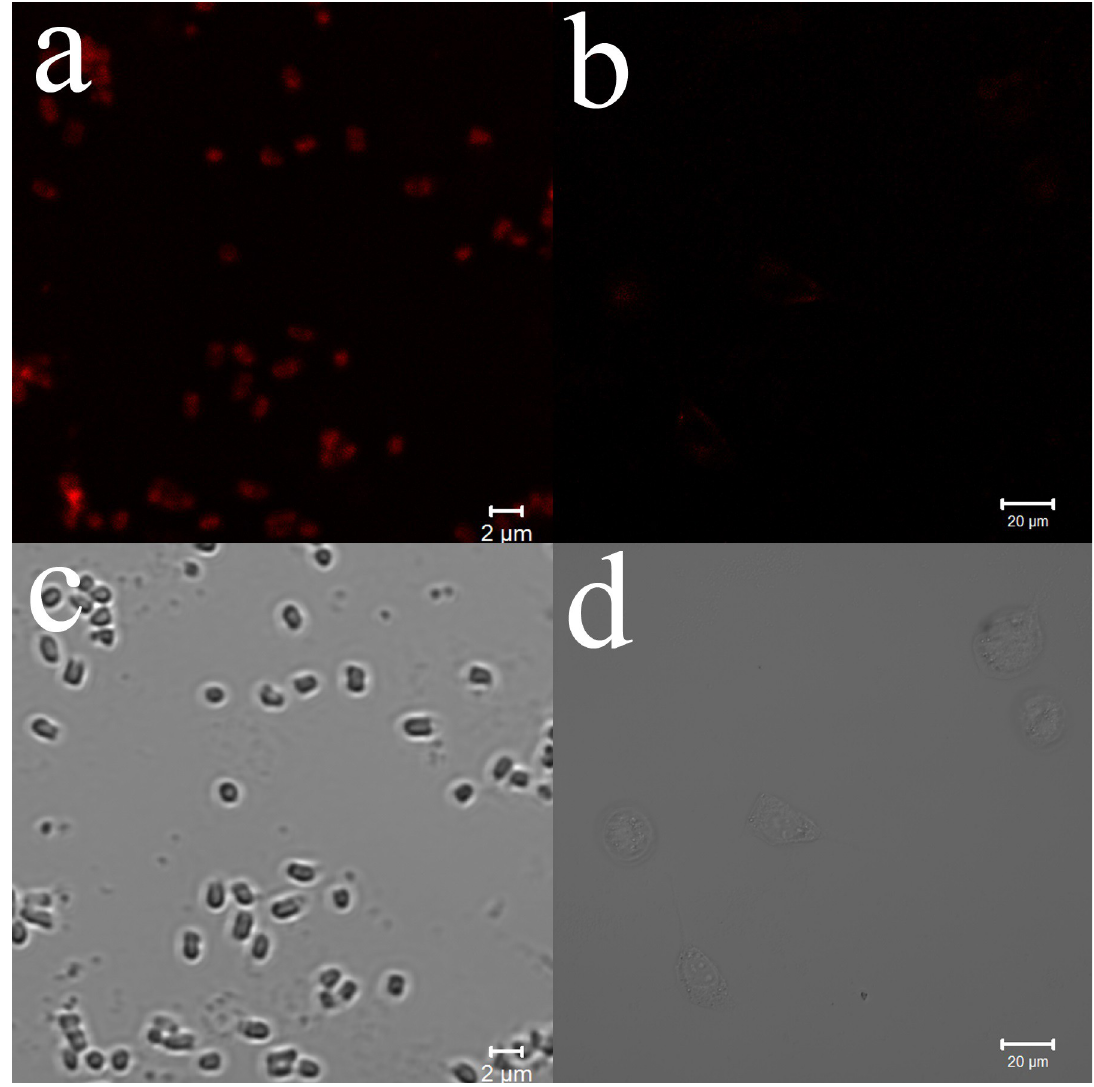
Fig 6. Confocal laser-scanning microscopy of (a) Pseudomonas aeruginosa and (b) NIH3T3 cells after incubation with 12.5 μ M protoporphyrin IX–ethylenediamine derivative (PPIX-ED) for 30 min. (c) Optical image of untreated P . aeruginosa . (d) Optical image of untreated NIH3T3